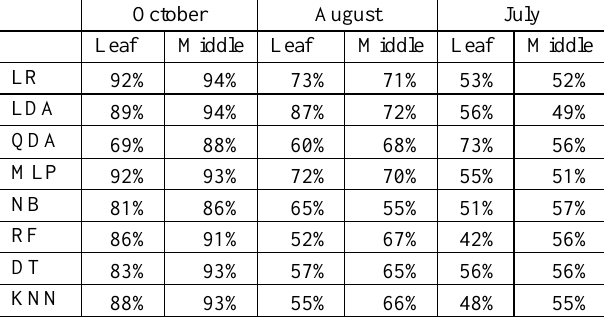
Table 3. Prediction accuracies for Loureiro in three